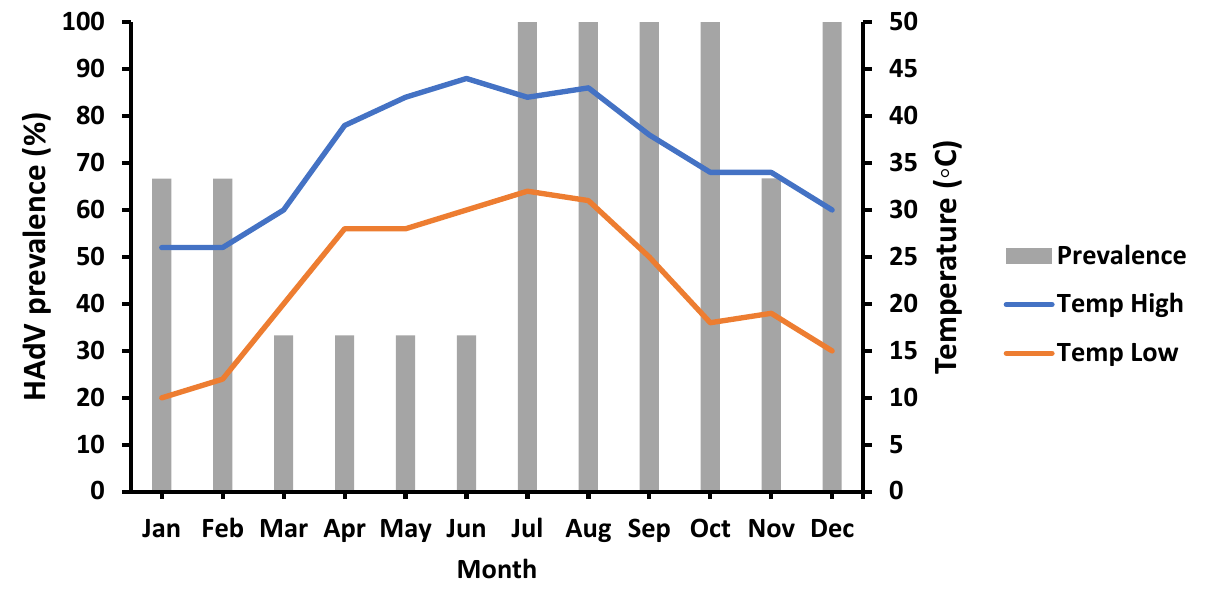
Table 2. Impact significance of environmental factors on the HAdV prevalence.